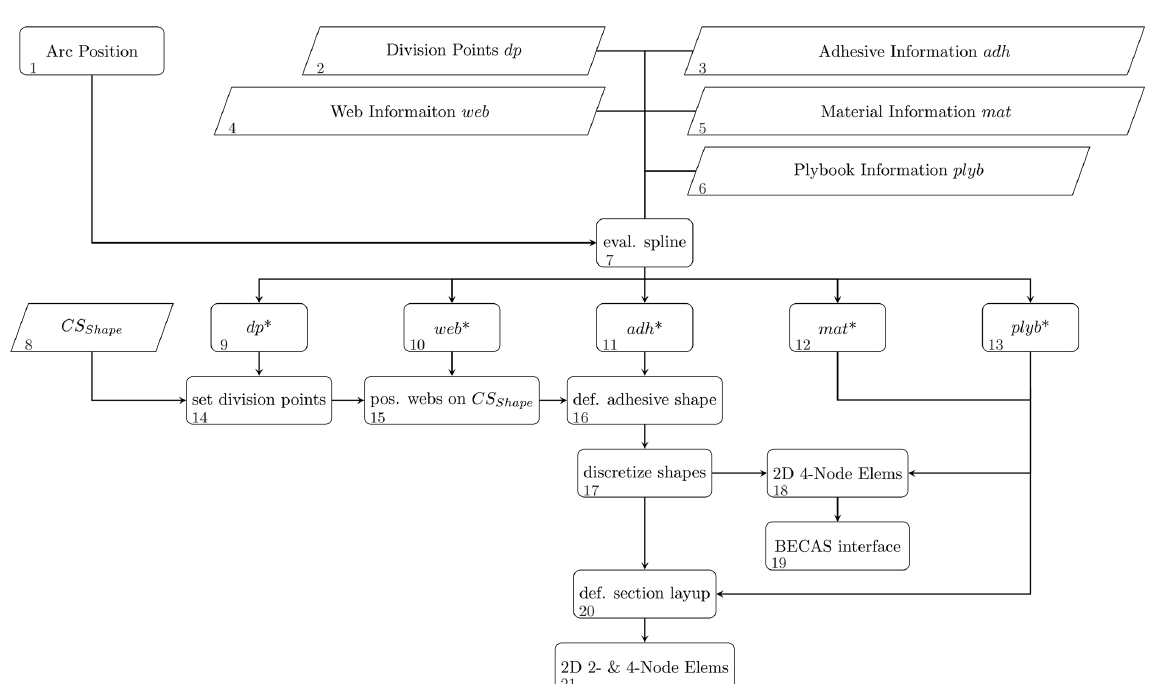
Figure 3. Flowchart of the 2D cross-sectional meshing routine in